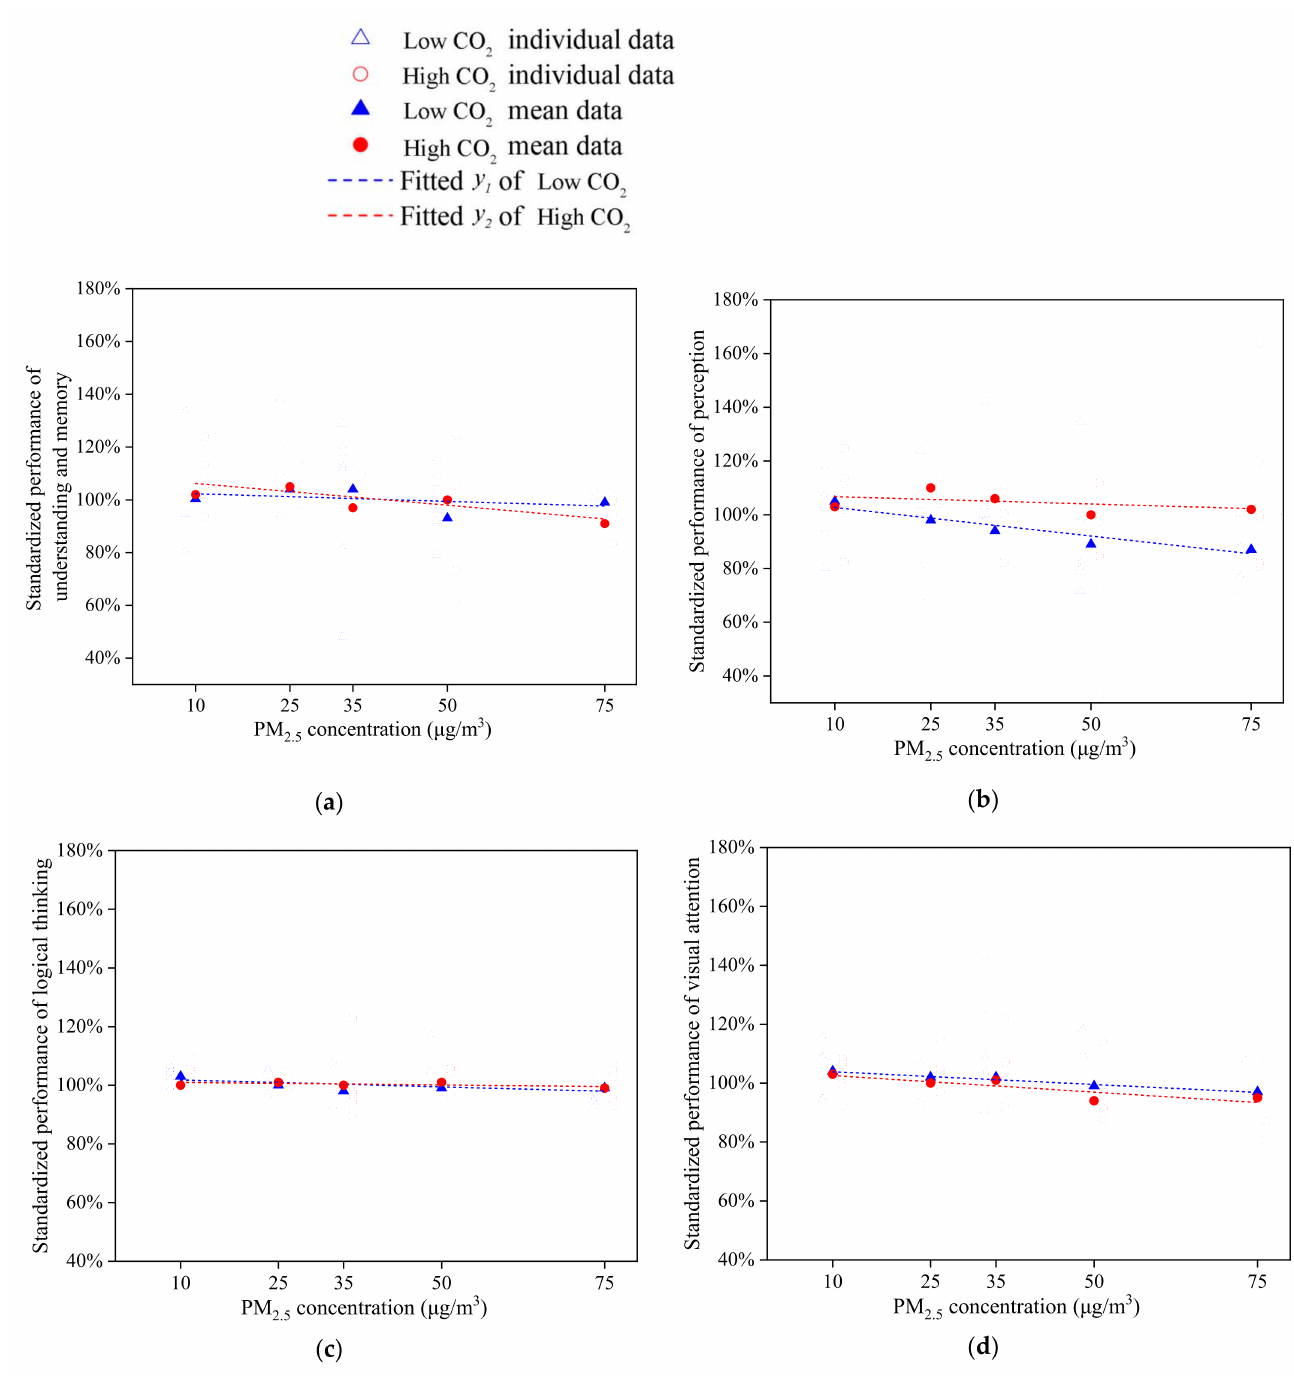
Figure 8. Standardized performances of four productivity